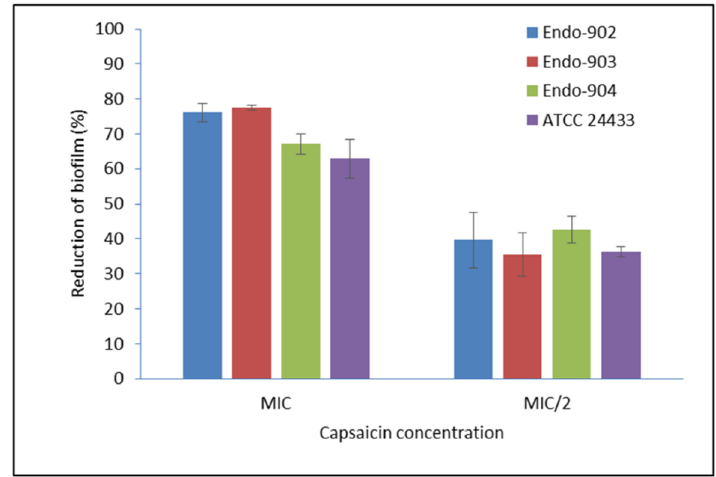
Figure 1. Effect of Capsaicin on the mature biofilm of C. albicans. The standard deviations (SD) of each sample are shown in the graph. The mean differences between the control and test molecules at the MIC level were statistically significant ( p ‐ level, 0.01). MIC/2—half of the MIC concentration; Endo—endodontic isolates.